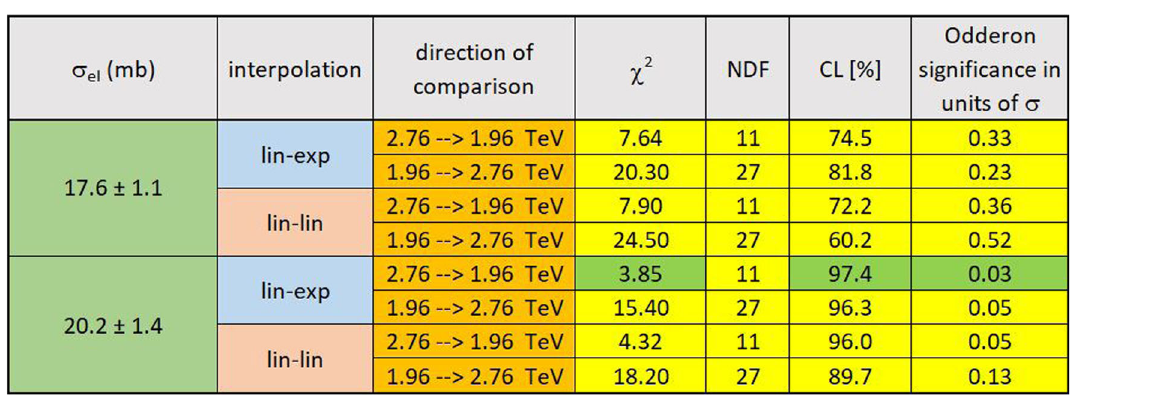
Table 3 Summary table of the search for an Odderon signal in the one-way comparison of the H ( x ) scaling functions of pp collisions at √ s = 2 . 76 TeV measured by the TOTEM experiment at the LHC, and